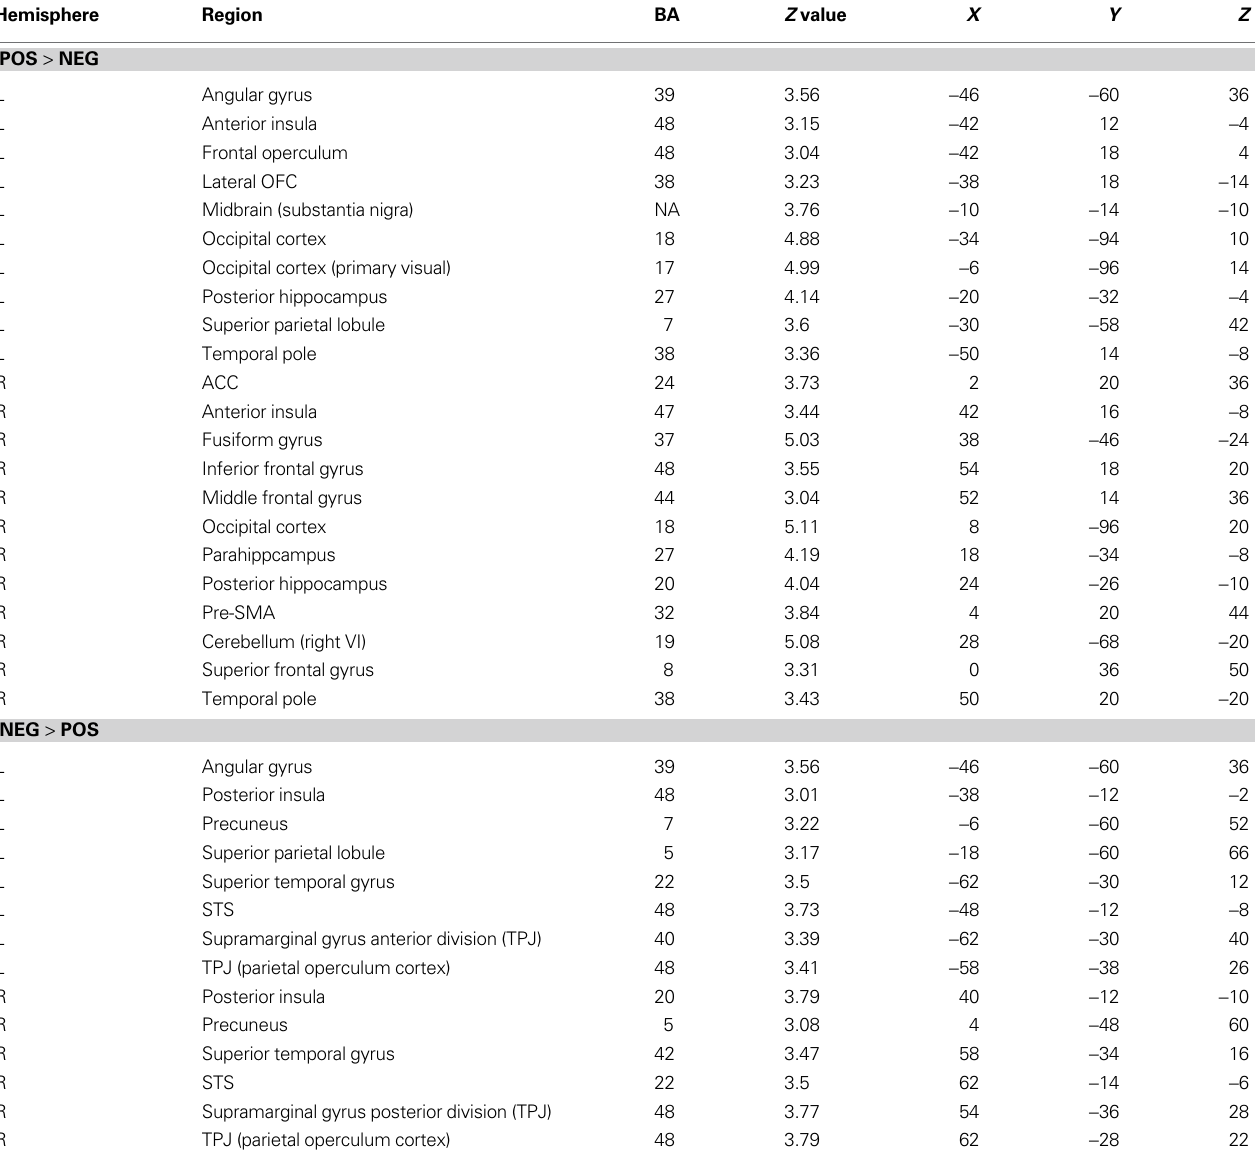
Table 1 | Brain regions associated with expectation error. Hemisphere Region BA Z